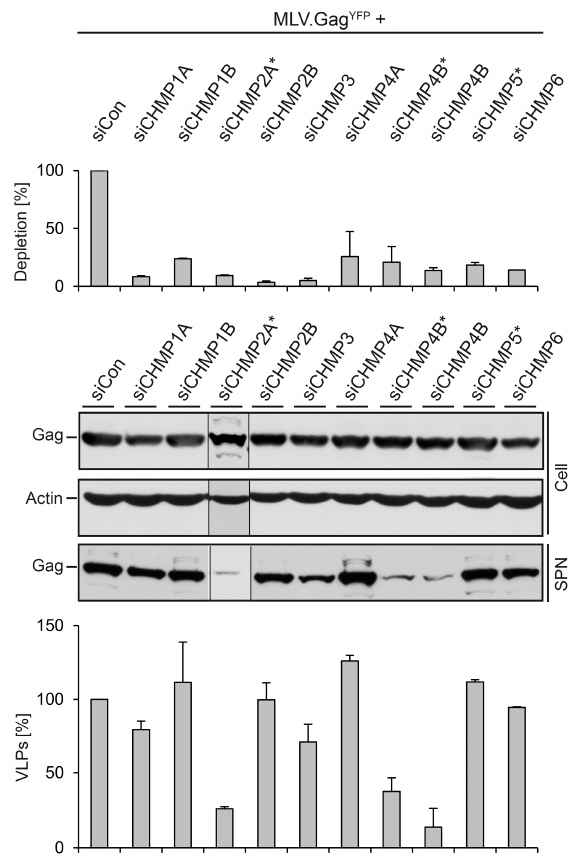
Figure 4. Impact of ESCRT-III family members on MLV.Gag YFP release. HuH-7 cells were transfected with siRNAs targeting the indicated ESCRT-III genes and retransfected with MLV.Gag YFP . In cases where single siRNA duplexes were used, the target gene is designated with a star. The degrees of ESCRT-III knockdowns were measured by qRT-PCR. PCR runs were performed in duplicate, and error bars are standard error of the mean ( top panel). Synthesis (Cell) and release (SPN) of MLV.Gag YFP were probed by GFP-specific WB. Uniformity of sample loading was assessed by anti-ß-Actin WB ( middle panel). VLPs values were quantified by densitometric analysis and demonstrated in percent amount relative to control cells in the graph below. Error bars indicate the standard deviations from the mean of two experiments ( bottom panel).